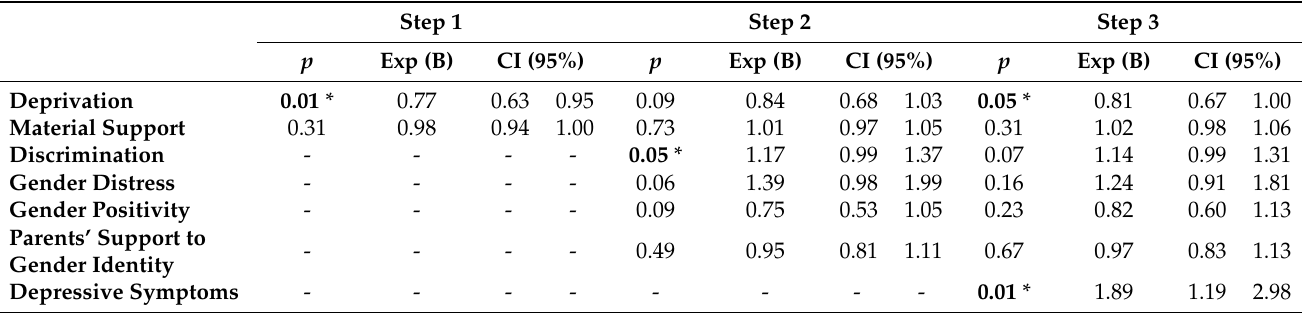
Table 5. Poisson Regression—suicide